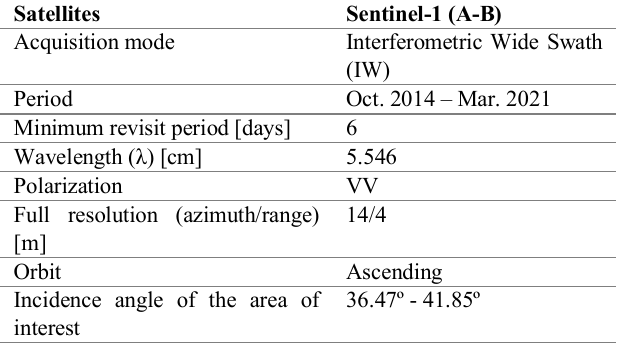
Table 1. Summary of the dataset analysed The methodological process of SAR image acquisition and processing is outlined in the following diagram (Figure 4). The